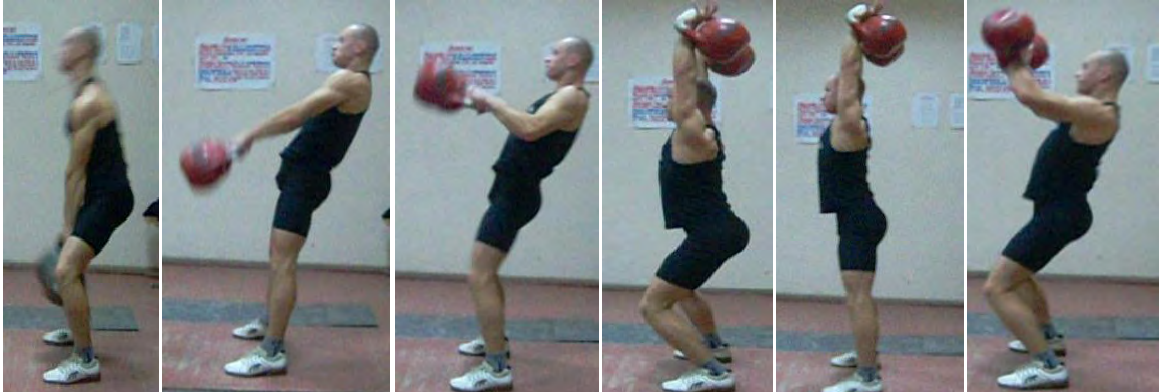
Fig.2. Technique of snatch by two arms (32 kg) with heels’ full contact with floor